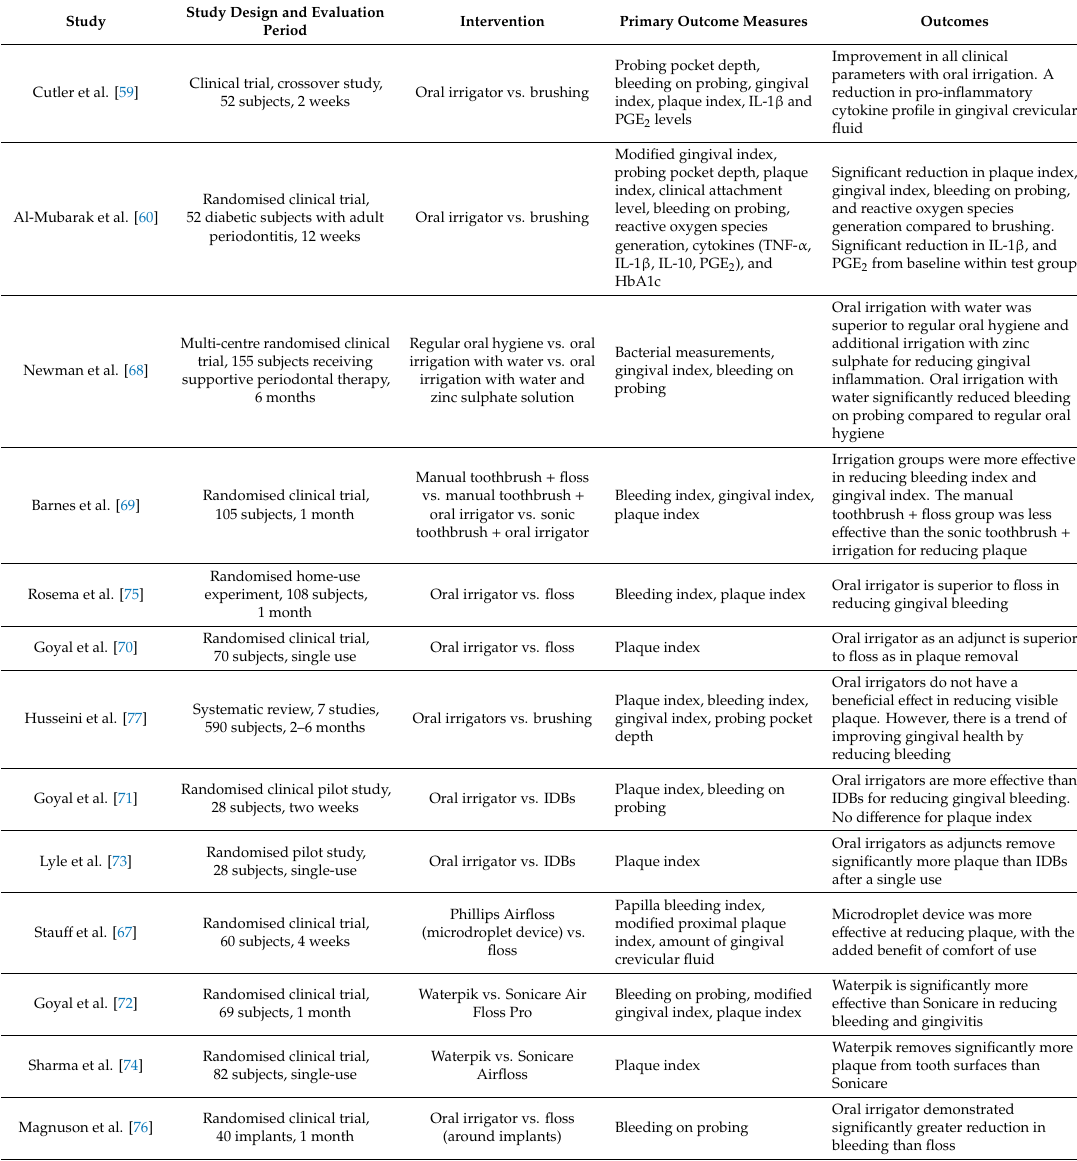
Table 4. Summary of included studies on oral